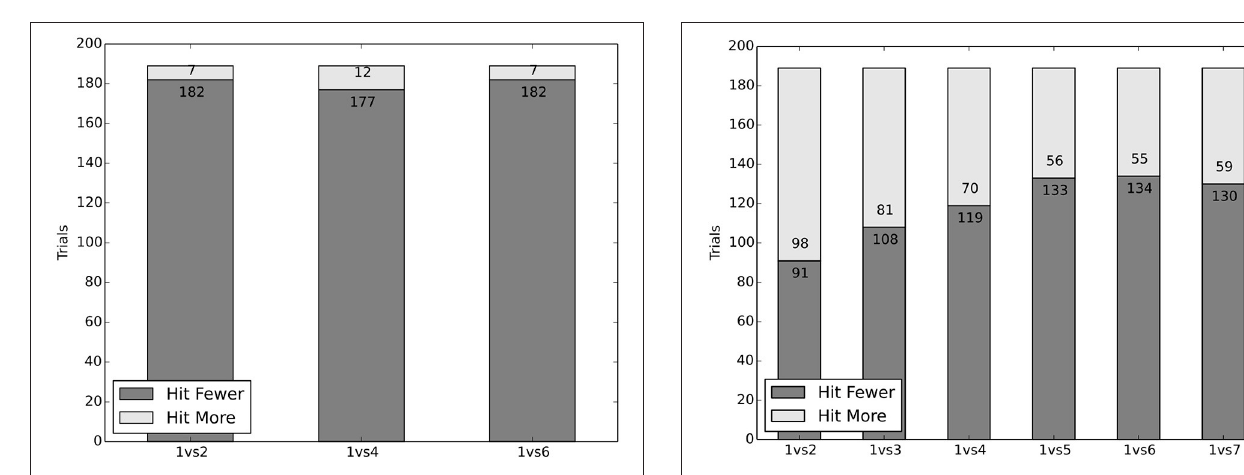
FIGURE 1 | Results of classic trolley dilemma were